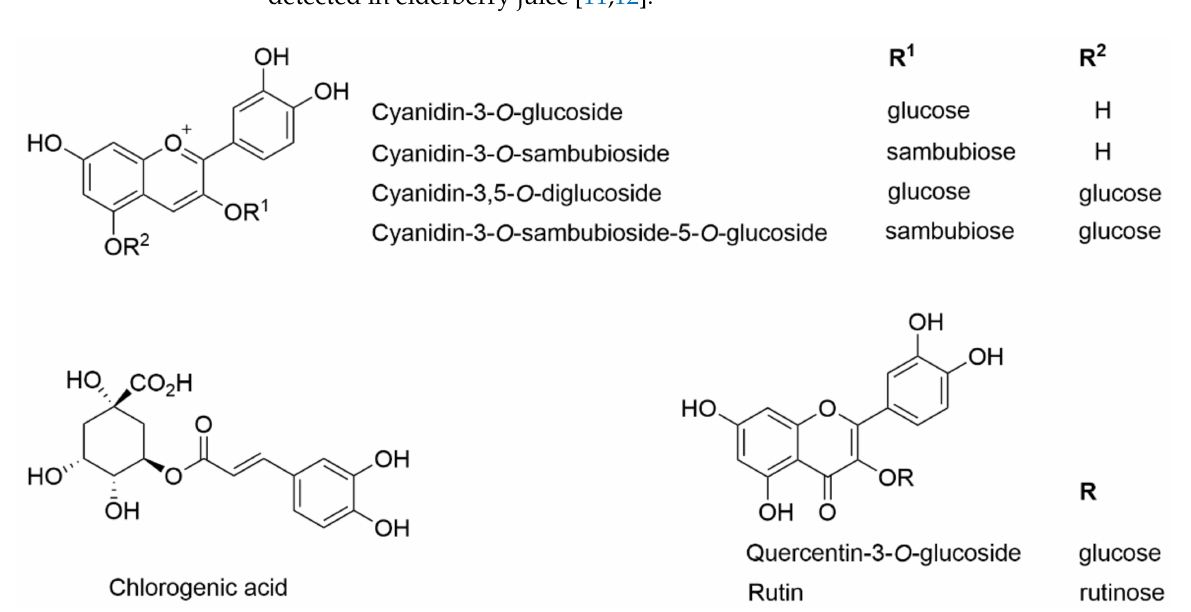
Figure 1. Some polyphenols identified in elderberry ( Sambucus nigra L.) juices and concentrates